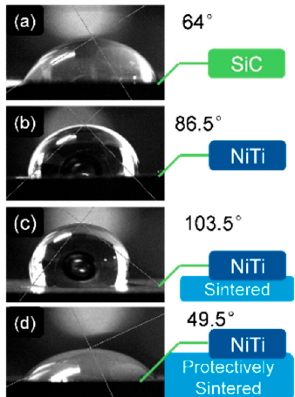
Figure 11. The contact angle test of the different samples with distilled water in the air: ( a ) the as-received SiC substrate; ( b ) the SiC surface coated NiTi without sintering; ( c ) the SiC surface coated NiTi after sintering (without sponge titanium); and ( d ) the SiC surface coated NiTi after the protective-sintering (with sponge titanium).